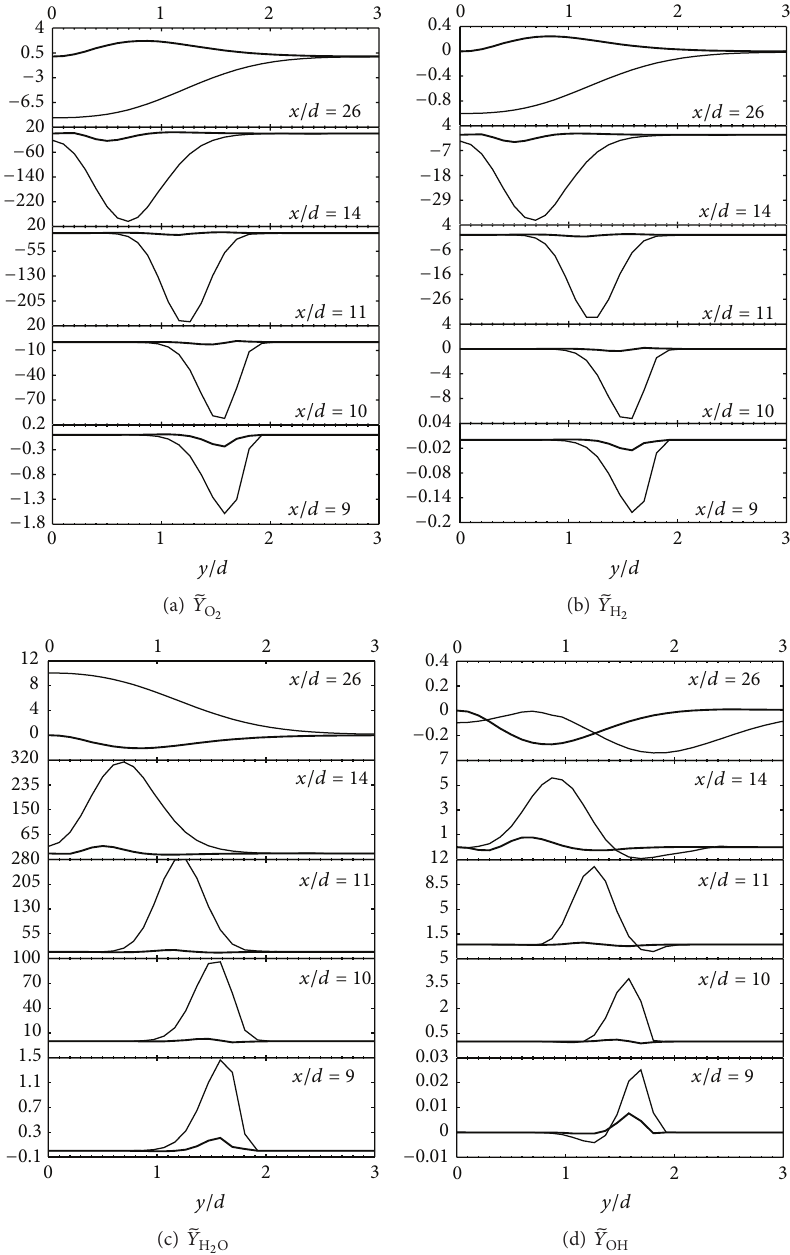
Figure 12: Radial profiles of the chemical and spurious sources for 𝑇 𝑐 = 1045 K: (a) O 2 , (b) H 2 , (c) H 2 O, and (d) OH. Thin lines, chemical sources; thick lines, spurious sources. The units are s −1